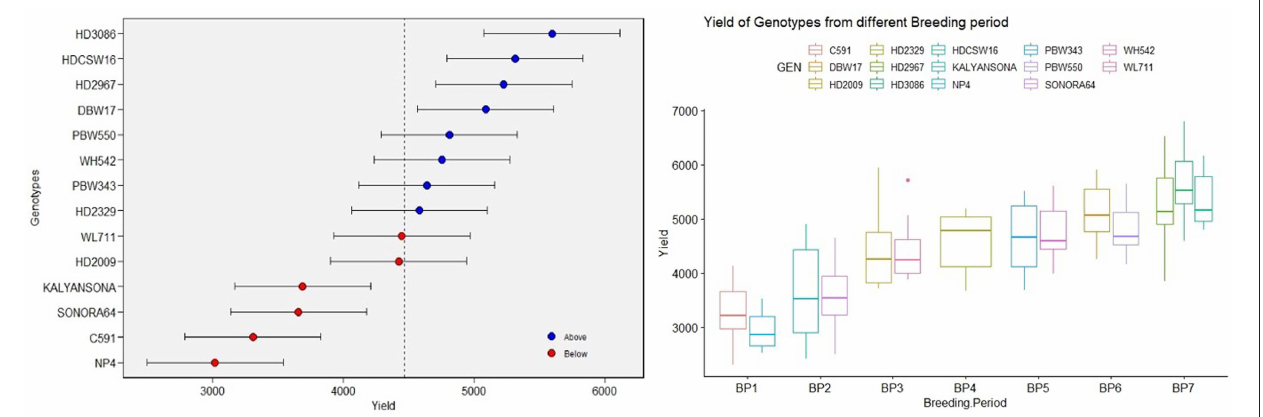
FIGURE 1 | The box plot [based on the best linear unbiased prediction (BLUP)] of yield over varieties under timely sown conditions and yield of varieties from different breeding periods.